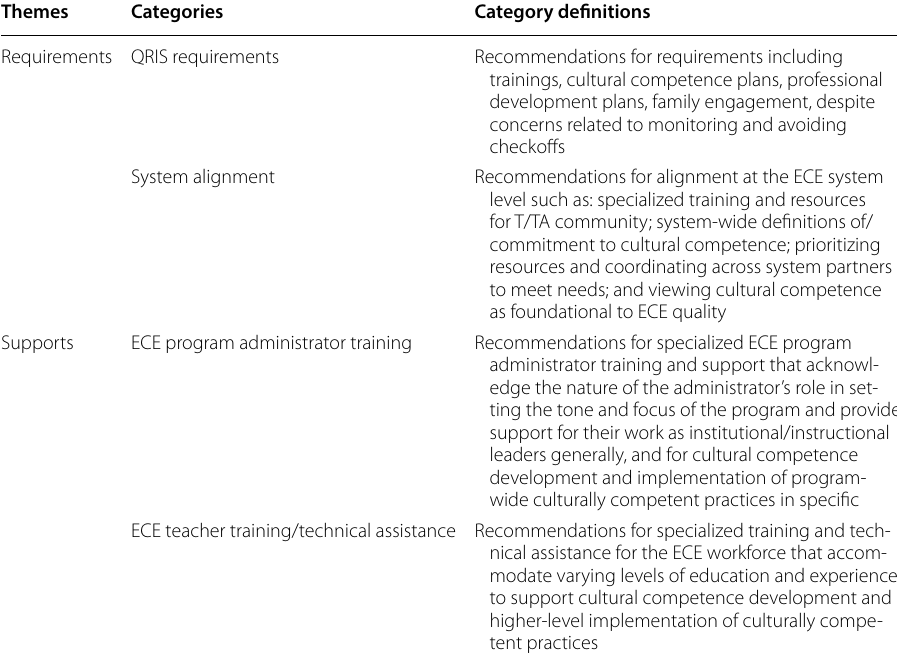
Table 3 Themes, categories, and